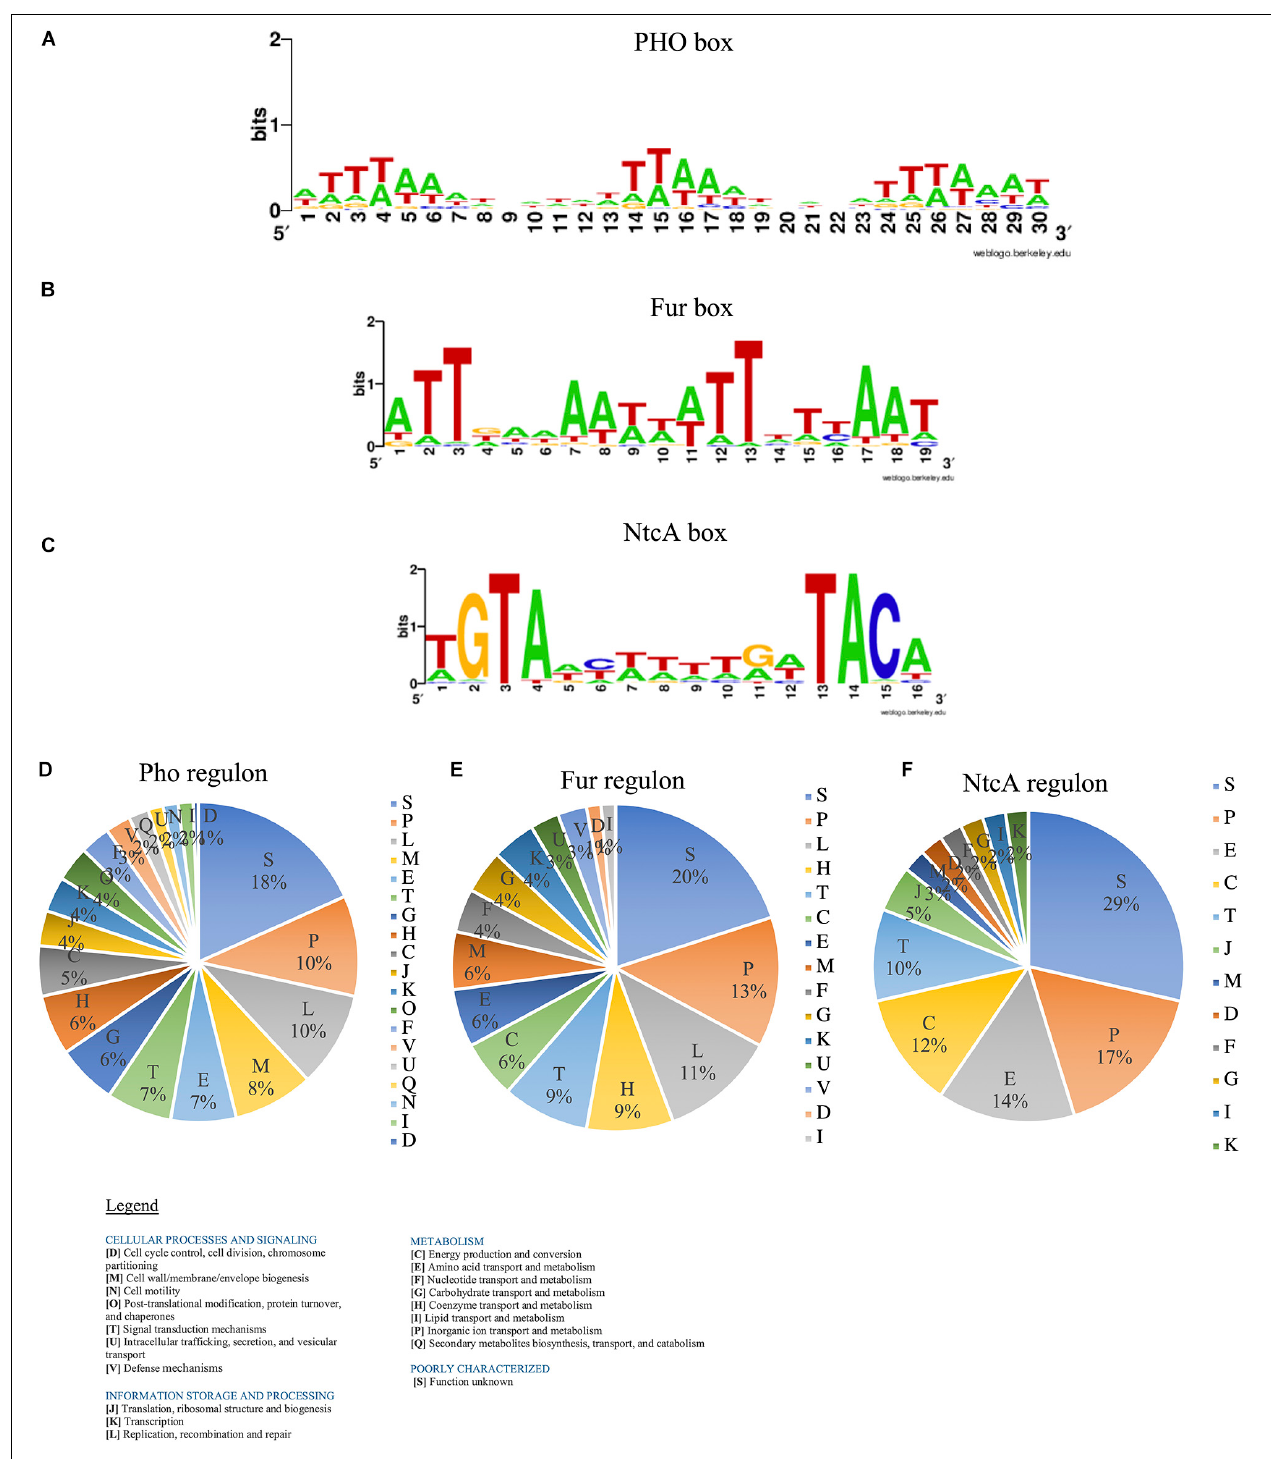
FIGURE 8 | Transcriptional binding sites (TBS) for PhoB, Fur, and NtcA regulators predicted for Halothece sp. (A) PHO box, (B) Fur box, and (C) NtcA box in Halothece sp. The Markov models were built with WebLogo. (D–F) Single-letter functional codes (COGs) for (D) Pho regulon, (E) Fur regulon, and (F) NtcA regulon in Halothece sp. PO 43 − is represented as